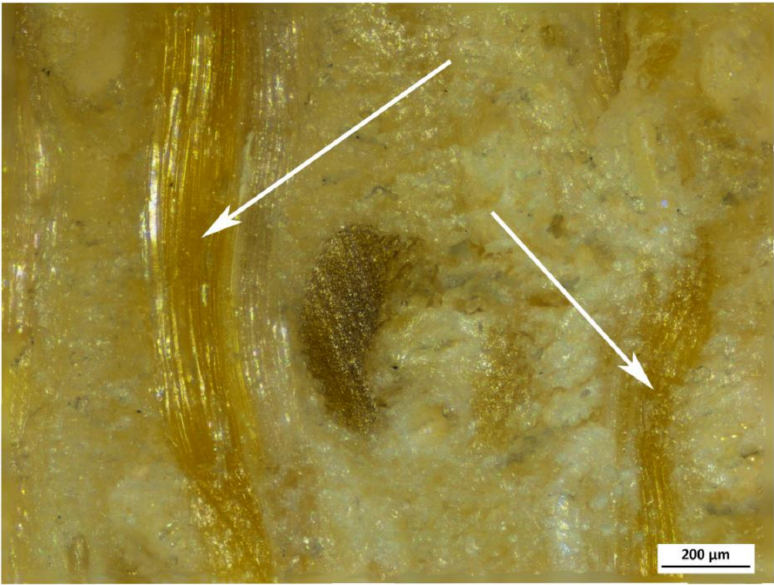
Figure 6. Optical micrograph from the transversal cut in a node of AA bamboo.